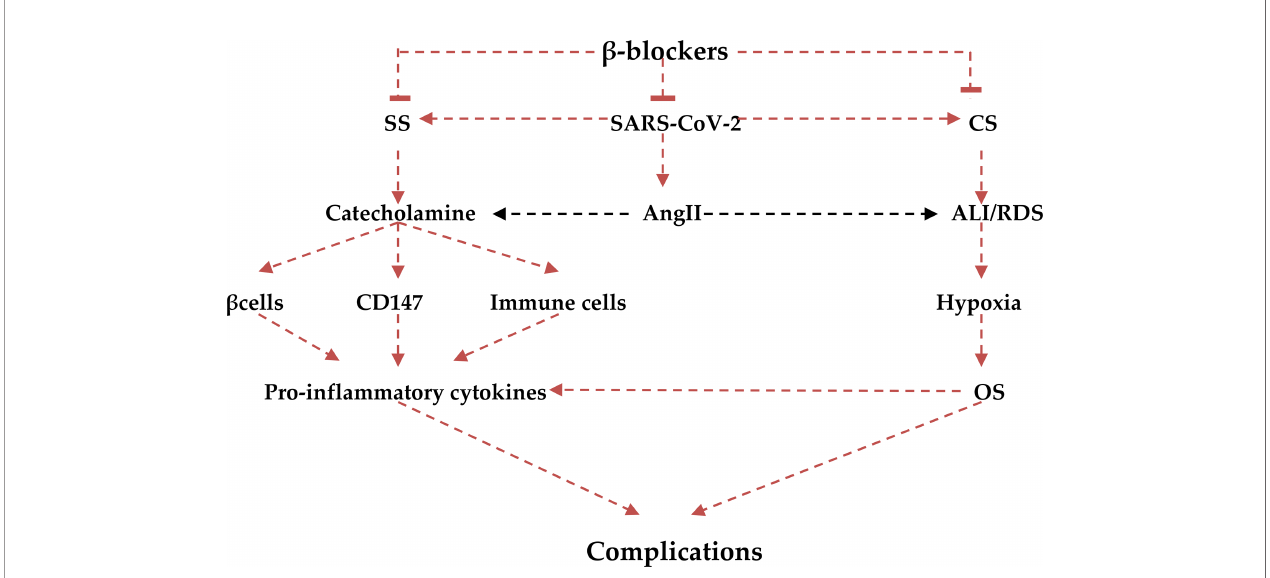
FIGURE 7 | Role of b -blockers in the irruptions of the crosstalk between cytokine (CS) and sympathetic storms(SS): b -blockers block reduces the release of catecholamine and decreases its stimulatory effect on b 2, CD147, and immune cells with reduction release of pro-in fl ammatory cytokines. The anti-in fl ammatory effects of b -blockers also attenuate CS-induced acute lung injury (ALI) and acute respiratory syndrome (ARDS), development of oxidative stress (OS), and fi nal systemic